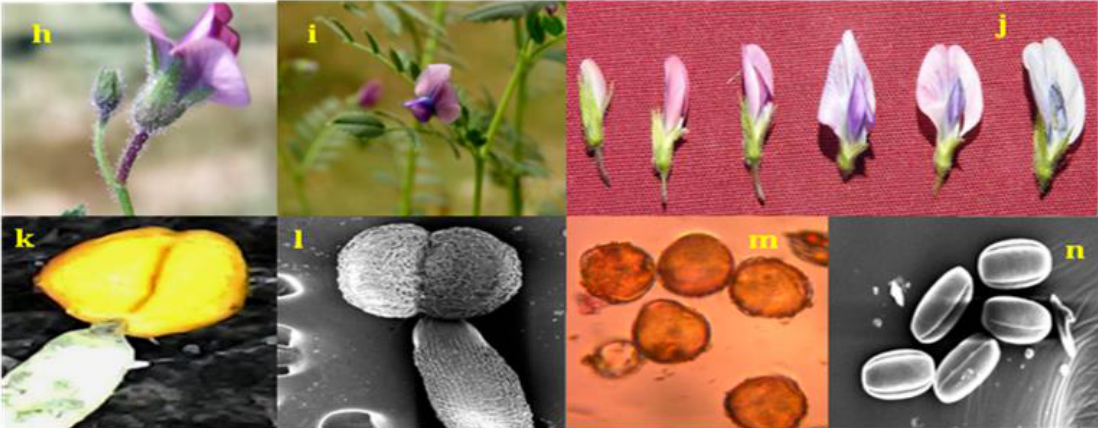
Figure 4. Images showing the effect of cold stress (above) and cold acclimation (below) on chickpea genotypes (reproductive phase). Cold stress effects from genotype ICC 15567 (cold-sensitive): aborted flower ( a ), flower with exposed anthers ( b ), developmental changes leading to abortion of flower ( c ), damaged anthers ( d , e ), and distorted and shriveled pollen grains ( f , g ). Cold acclimation effects from genotype ICC 16349 (cold-tolerant): flowers ( h , i ), developmental changes in cold-acclimated flowers ( j ), cold-acclimated anthers ( k , l ), and cold-acclimated viable pollen grains ( m , n ).